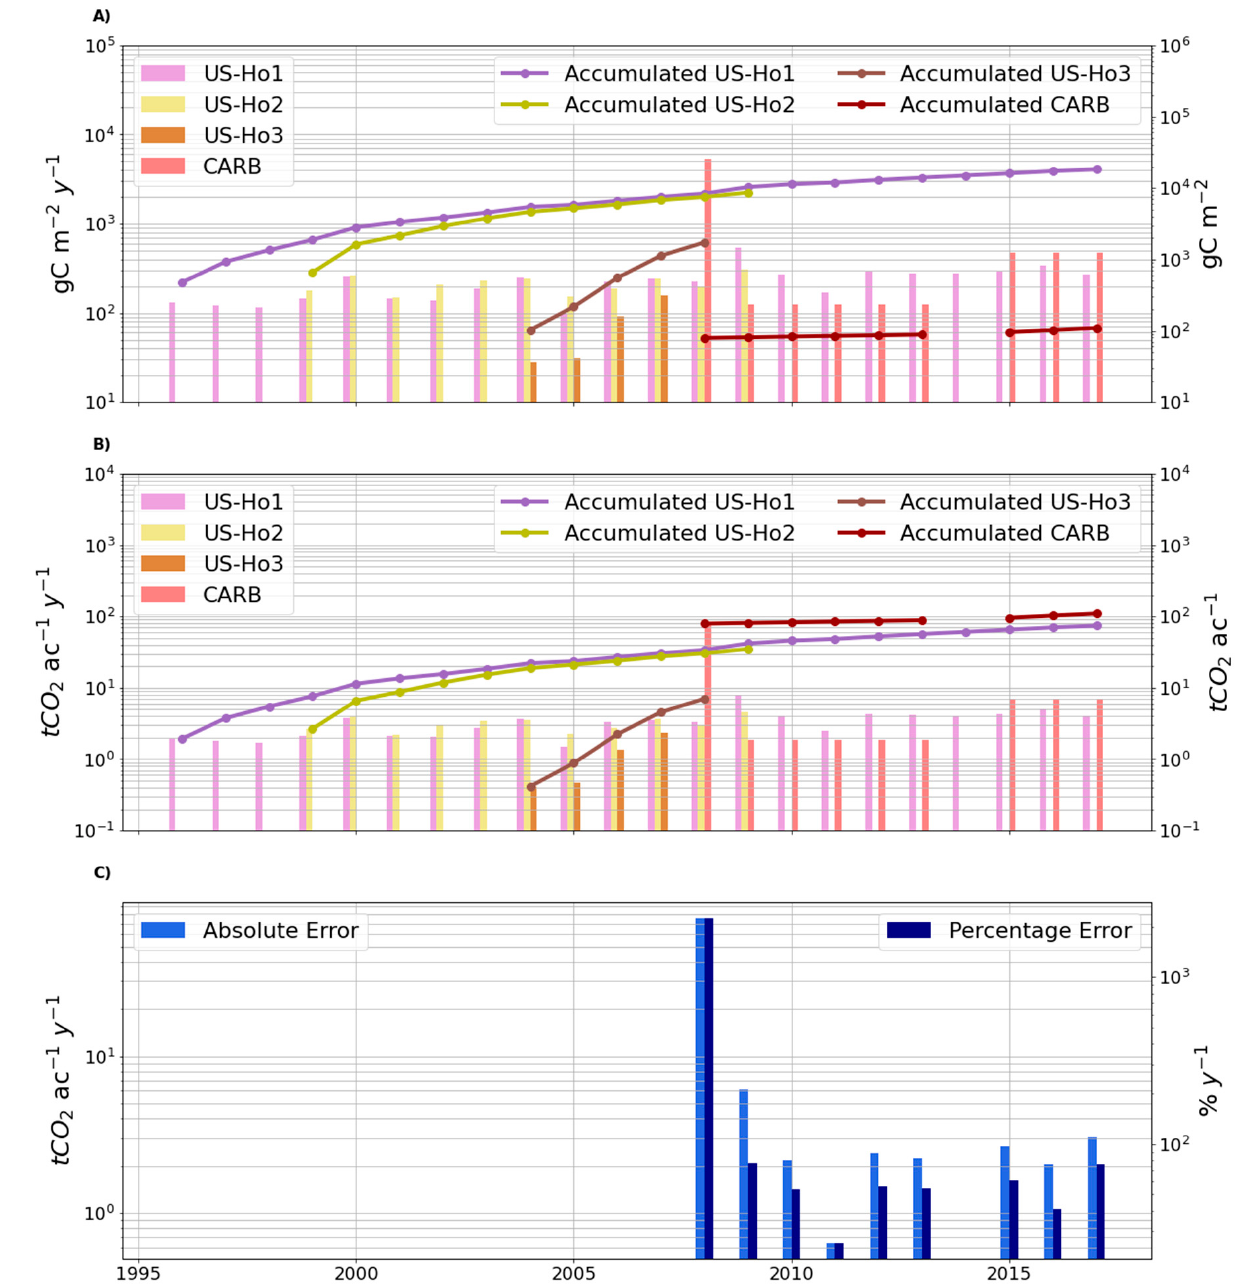
Figure 2. Yearly net ecosystem exchange (NEE) budgets (bars) and accumulated values (lines) for US-Ho1 (purple), US-Ho2 (green), US-Ho3 (brown) towers and for CARB (red) data in log-scale and in ( A ) grams of carbon per square meter and ( B ) tons of CO 2 per acre. ( C ) Absolute and percentage CARB yearly errors based on direct measurements from US-Ho1, in log-scale. Negative error values were made positive to include them in the log scale. A table of errors is provided in the Supplement Table S6.